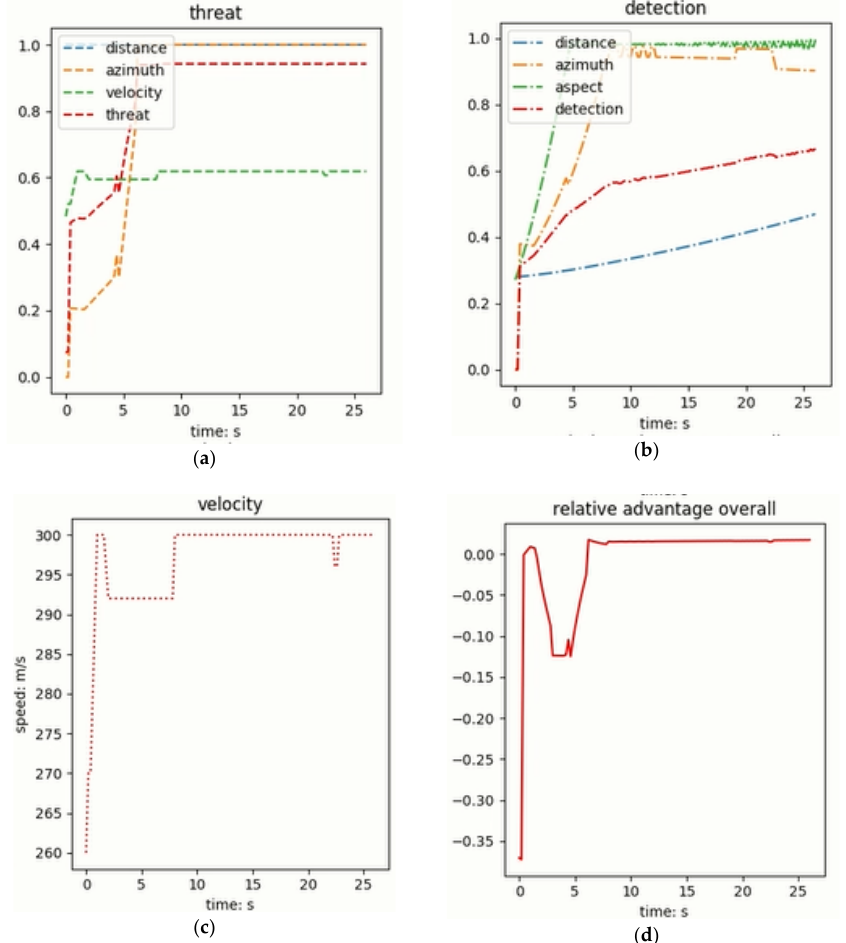
Figure 14. 2D disadvantage: native data change: ( a ) Threat ability; ( b ) Detection ability; ( c ) Speed; ( d ) Relative advantage.